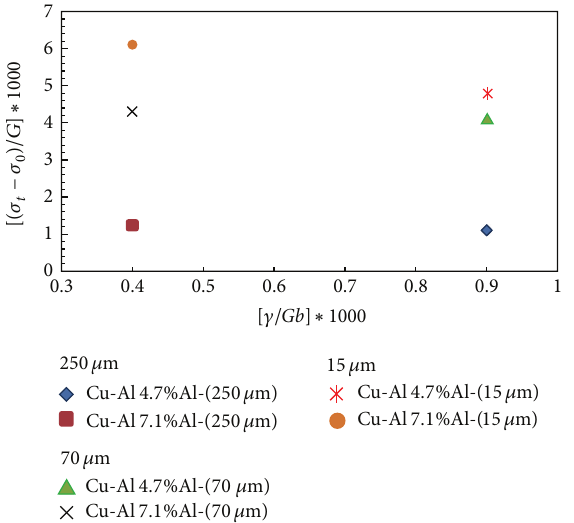
Figure 9: [(𝜎 𝑡 − 𝜎 𝑜 )/𝐺] ∗ 1000 at the onset of stage B for materials that displayed stage B (Cu-4.7Al and Cu-7Al) for the 70 and 250 𝜇 m and at strain of 0.1 for the 15 𝜇 m which did not display stage B versus normalized stacking fault energy [𝛾/𝐺𝑏] ∗ 1000 .